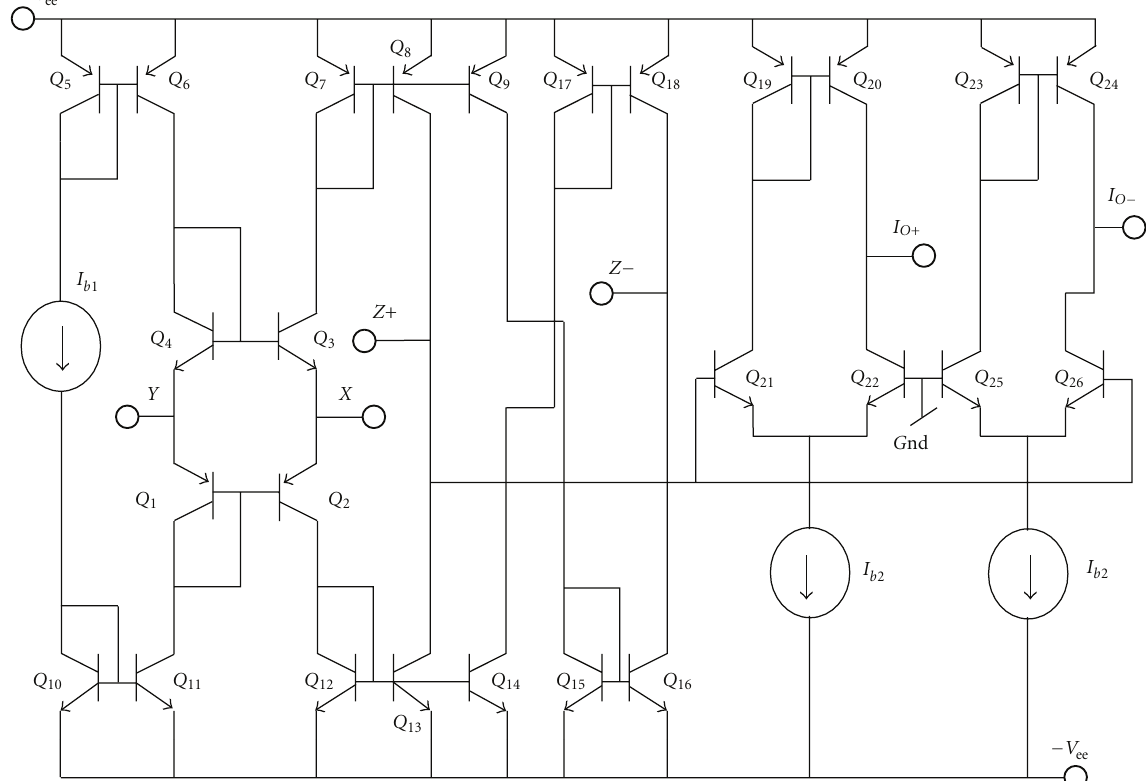
Figure 2: A possible bipolar implementation of the